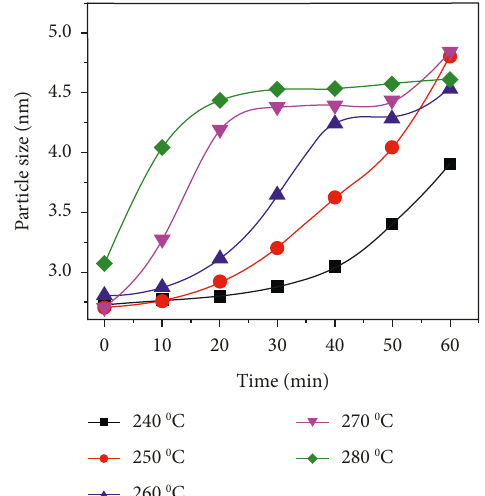
Figure 6: A plot of the average particle size of ZnS nanoparticles (obtained from UV-Vis spectra) against reaction time at different temperatures.